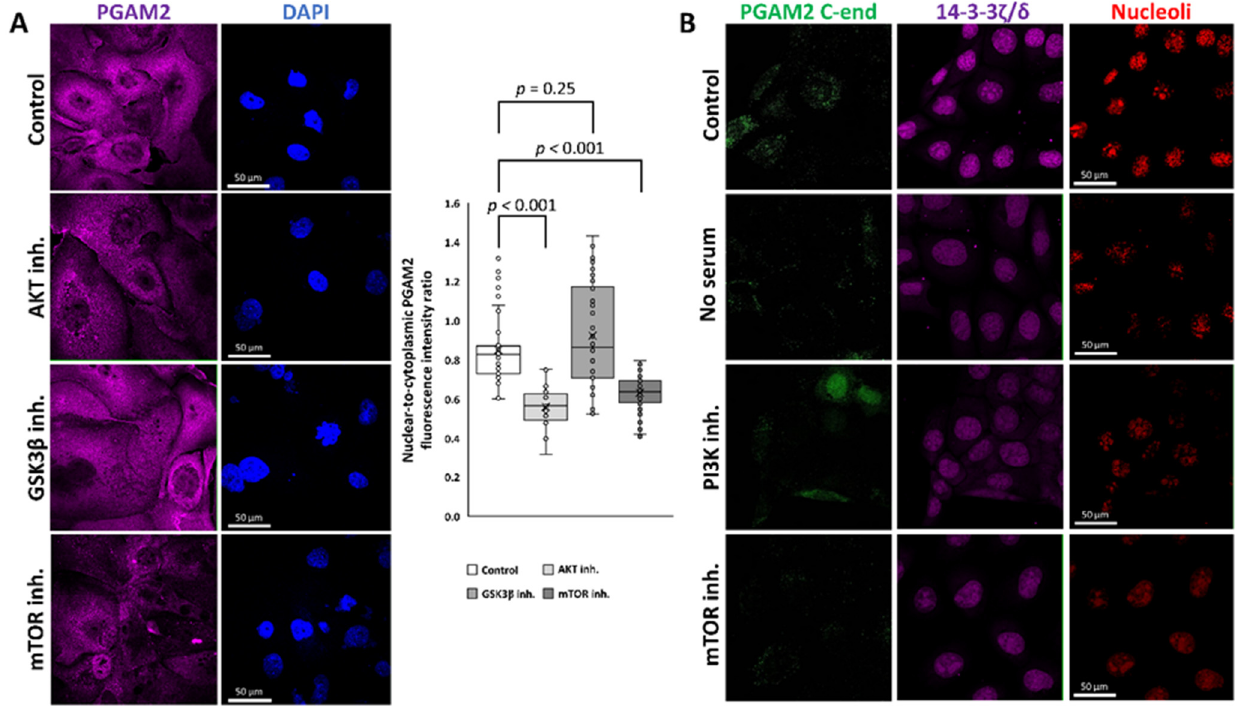
Figure 7. Regulation of nuclear localization of PGAM2. Immunodetection of PGAM2 showed that in the presence of Akt and mTOR inhibitors the protein nuclear retention is significantly reduced in comparison to untreated cells. In contrast, the inhibition of GSK3 β activity did not decrease the amount of nuclear PGAM2 ( A ). Additionally, the inhibition of the IGF1–PI3K–AKT–mTOR pathway abolished the nucleolar localization of PGAM2 ( B ).